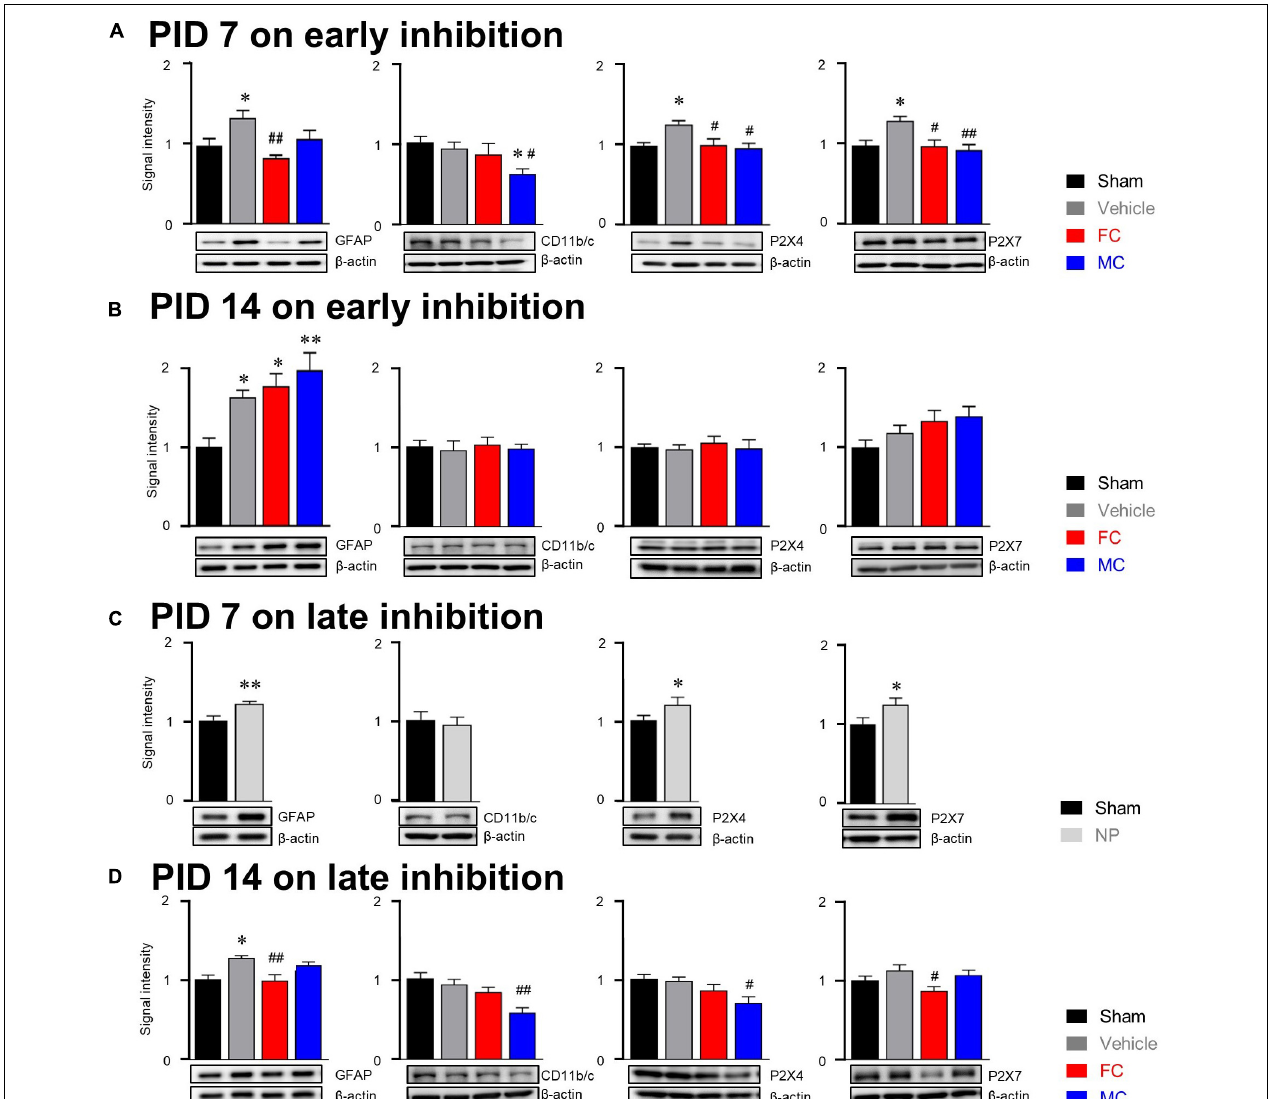
FIGURE 7 | Molecular alterations in glial cells after early and late inhibition. (A) On PID 7, expression changes in GFAP, CD11b/c, P2X4R, and P2X7R after early inhibition of glial cells. The GFAP, CD11b/c, and purinergic receptor expressions were significantly increased in the vehicle group. The FC-treated group ( n = 6) showed significant decrease in GFAP expression compared to the vehicle group. The MC group ( n = 6) showed significant decrease in CD11b/c expression compared to the sham and vehicle groups ( n = 6 each). The FC and MC groups showed significant decrease in P2X4R and P2X7R expressions compared to the vehicle group. (B) On PID 14 after early inhibition, expression changes in GFAP, CD11b/c, P2X4R, and P2X7R 7 days after withdrawal of inhibitors. The vehicle, FC, and MC groups showed significant increase in GFAP expression compared to the sham group ( n = 6each). There were no significant differences in CD11b/c, P2X4R, and P2X7R expressions between the groups. (C) On PID 7 after late inhibition, the expression of GFAP, P2X4R, and P2X7R in the NP group was significantly increased compared to the sham group ( n = 6). There was no significant difference in CD11b/c expression between the sham and NP groups. (D) Expression changes at the end of late inhibition (PID 14). The FC group showed significant decrease in GFAP and P2X7R expressions compared to the vehicle group. The MC group showed significant decrease in CD11b/c and P2X4R expressions compared to the vehicle group (sham, vehicle, FC, and MC; each group n = 4; error bars are SEM; ∗ p < 0.05; ∗∗ p < 0.01 vs. sham; # p < 0.05, ## p < 0.01 vs. vehicle, one-way ANOVA followed by Bonferroni’s post hoc multiple comparison